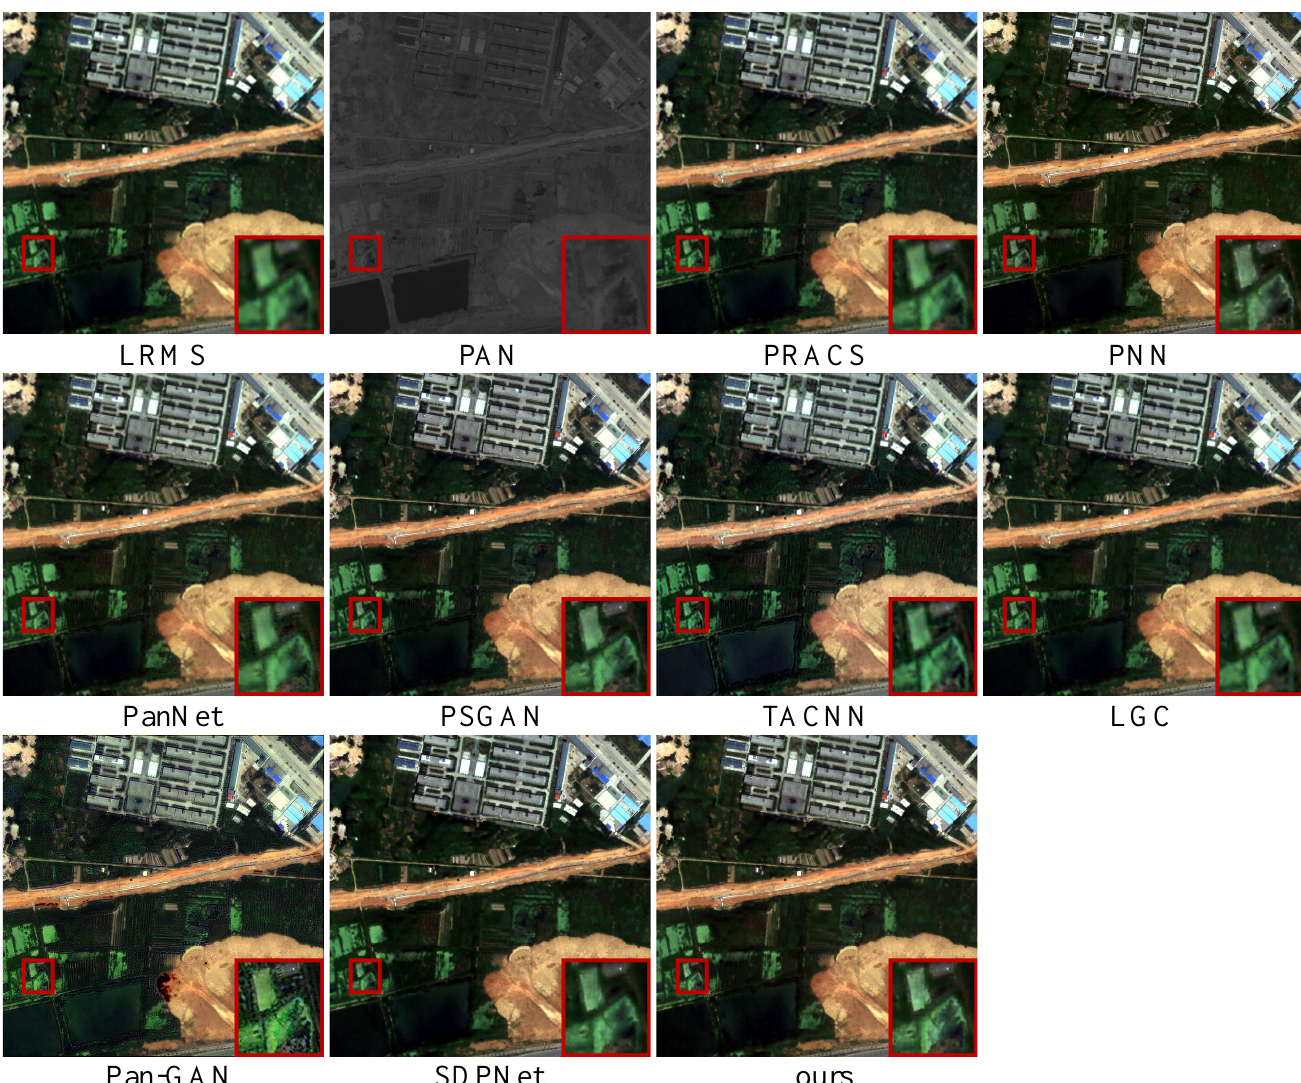
Figure 11. Qualitative comparison of CPNet with other eight pan-sharpening methods on the data from the QuickBird data set in full-resolution